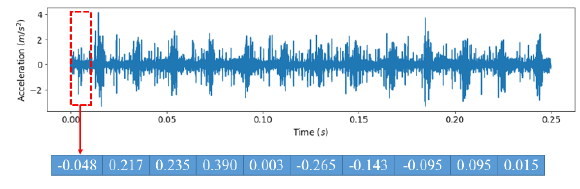
Fig. 1 First ten data points of a